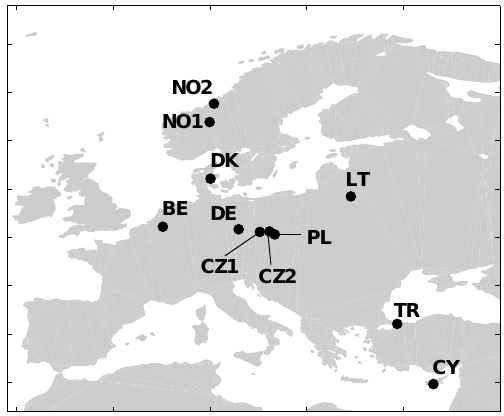
Figure 1. Location of the 11 catchments studied.